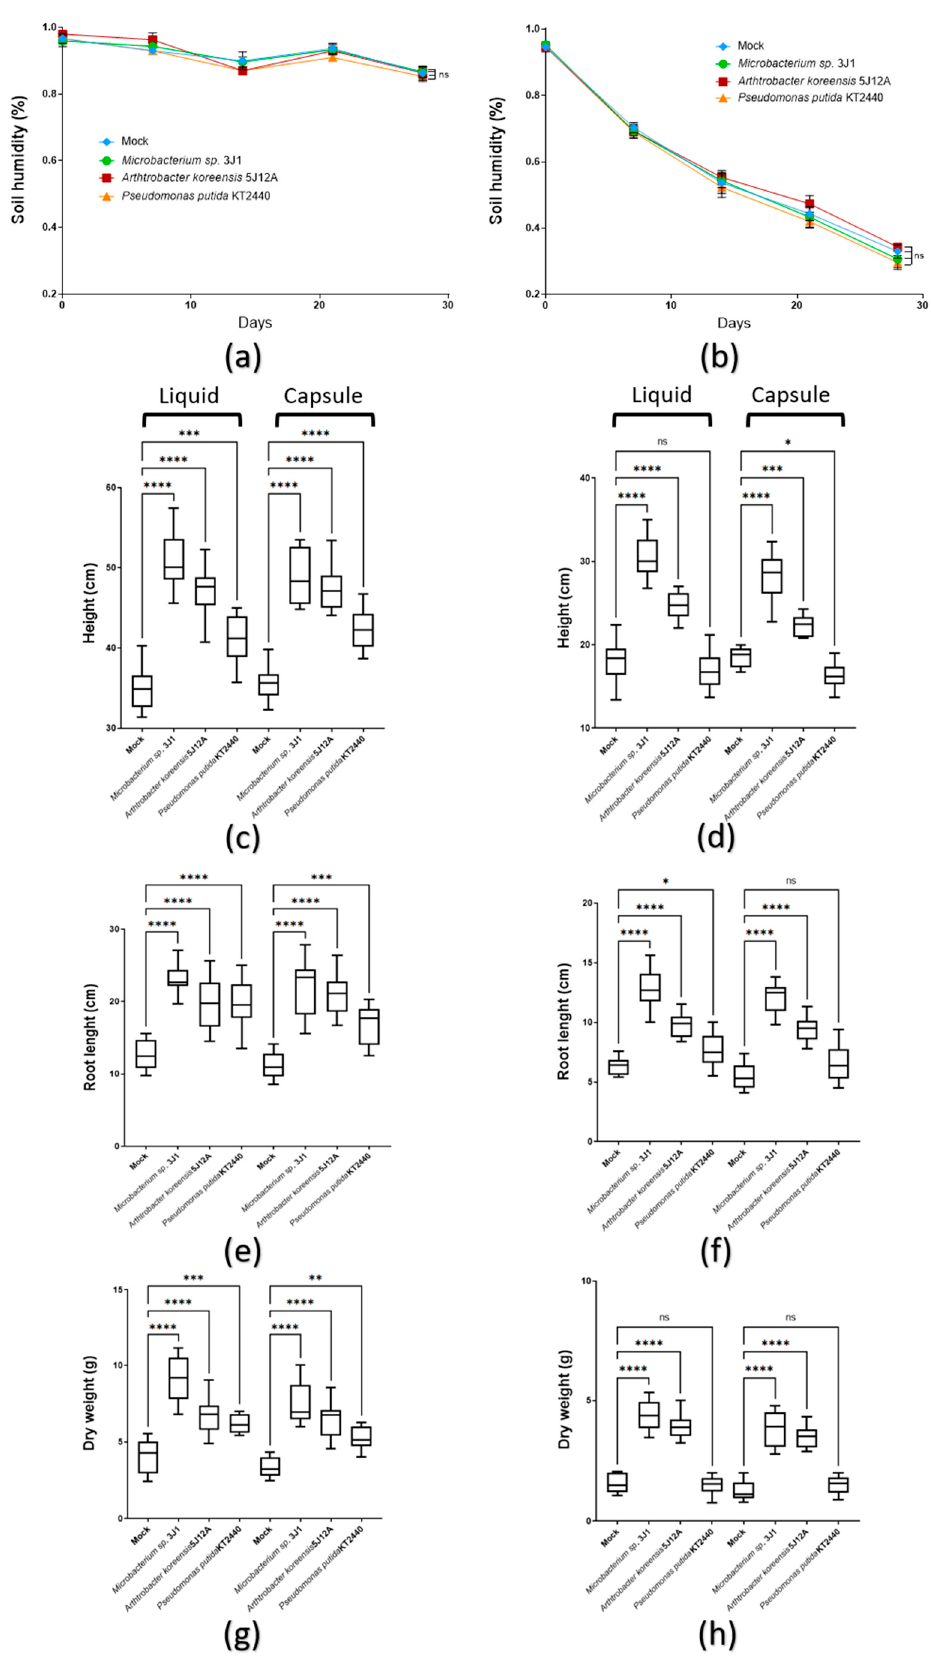
Figure 3. Capsule vs. liquid treatment effects on 30 DAT maize plants. ( a , b ) The line graphs show weekly soil humidity representative data from three independent experiments ( n = 9) under regular